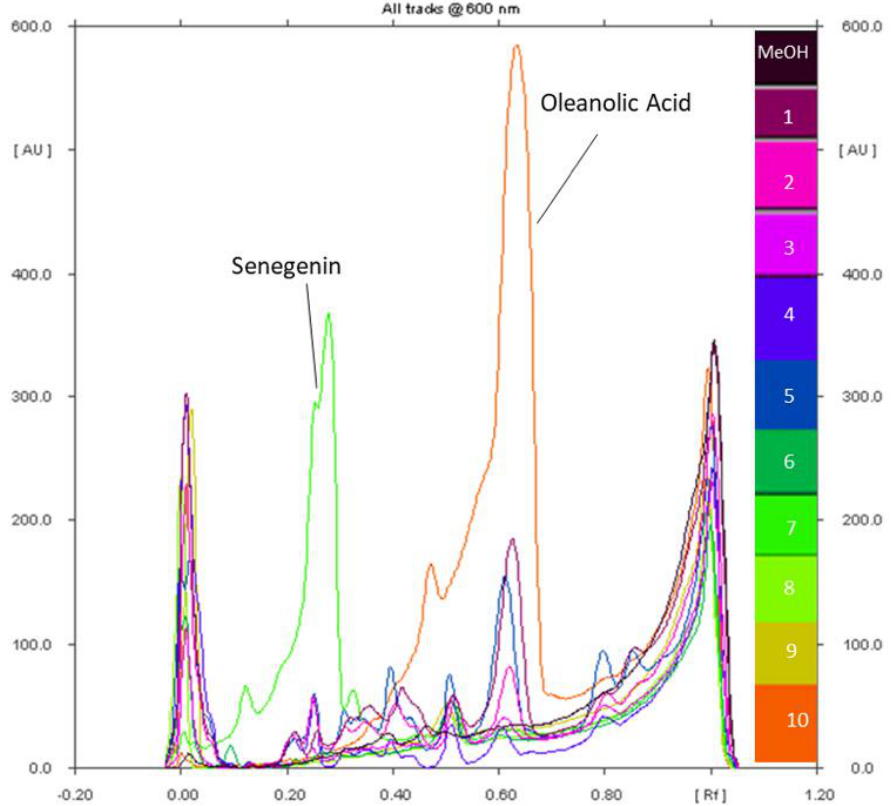
Figure 4. The densitometric chromatograms of the Zaghouan extracts (Tracks 1–5) and the standards (Tracks 6–10): solanine (Track 6), senegenin (Track 7), digitonin (Track 8), glucose-fructose (Track 9), and oleanolic acid (Track 10) at 600 nm after visualization with anisaldehyde-H 2 SO 4 .